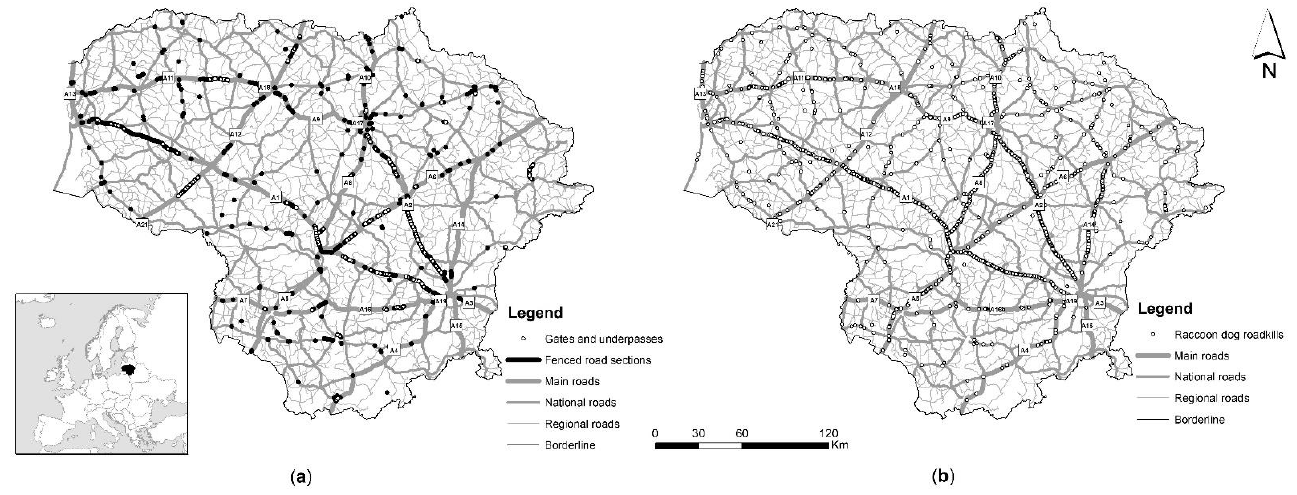
Figure 1. Road network of Lithuania ( a ) and registered raccoon dog roadkills in 2002 – 2020 ( b ).